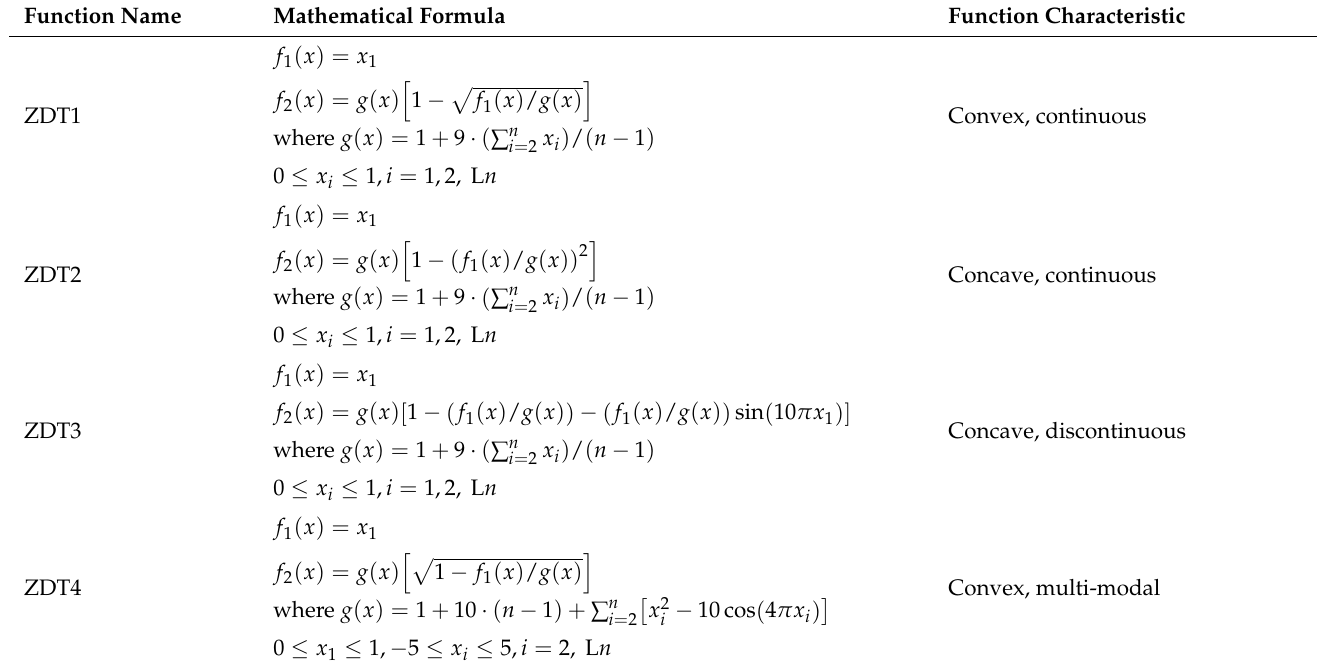
Table 1. ZDT test functions and characteristics.